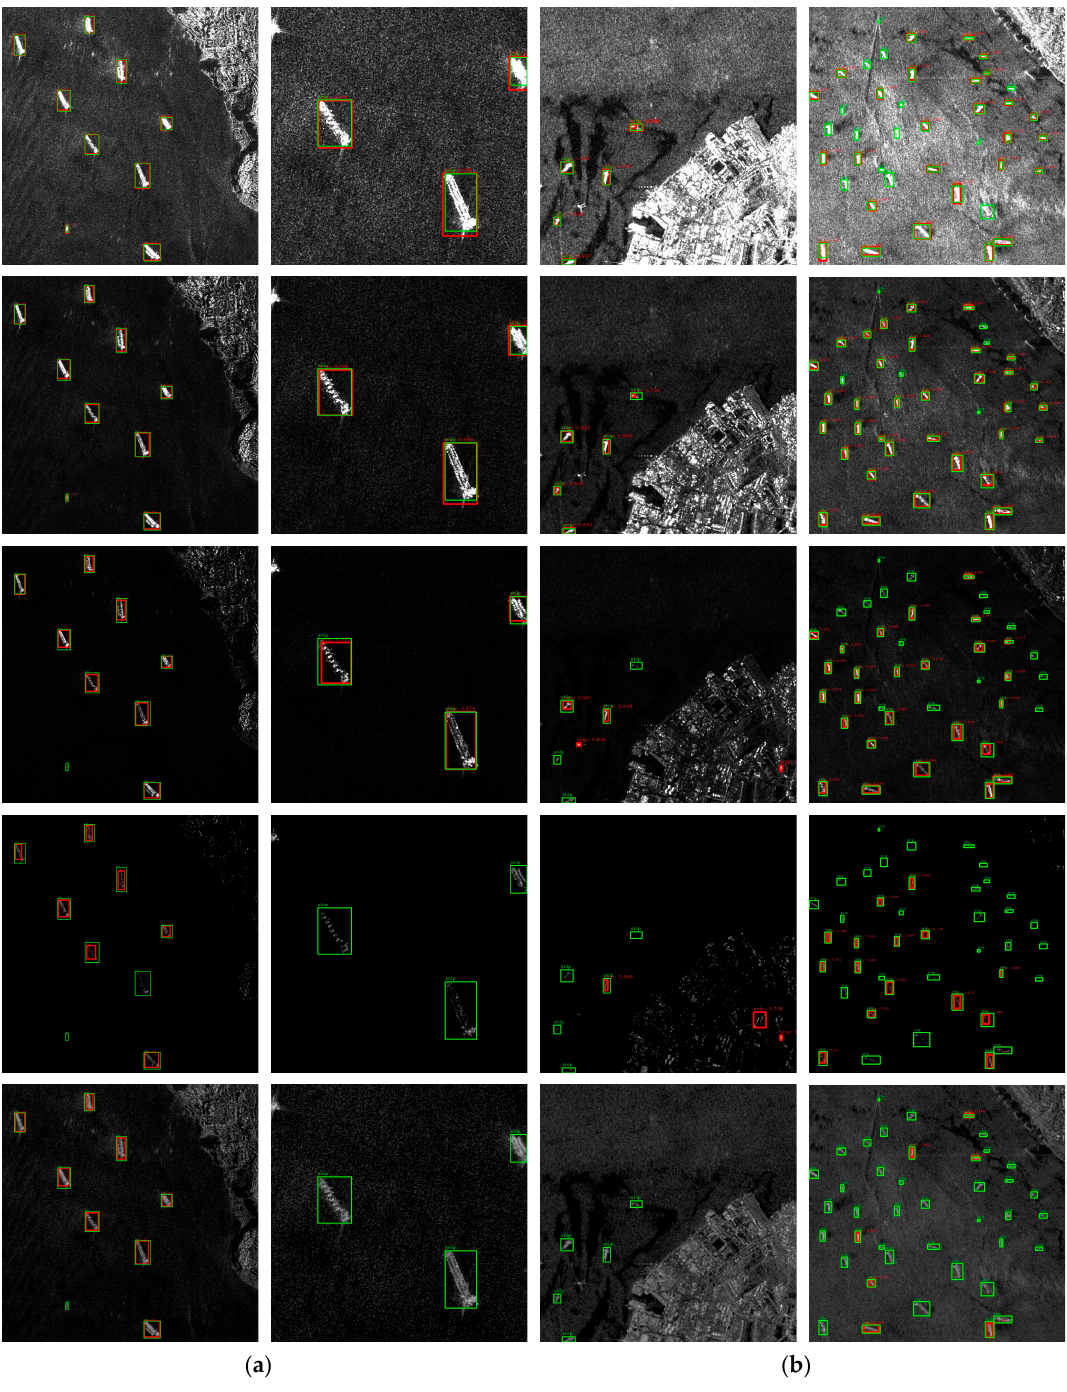
Figure 14. Ship detection results in the TerraSAR-X test image. Row 1 is the result of 0.008; Row 2 is the result of 0.02; Row 3 is the result of 0.05; Row 4 is the result of − 20 dB; Row 5 is the result of − 30 dB. ( a ) Partial result of HR-SDNet in the Strait of Gibraltar; ( b ) Partial the result of HR-SDNet in the Strait of Singapore. Red boxes denote predicted results; green boxes denote ground-truth.